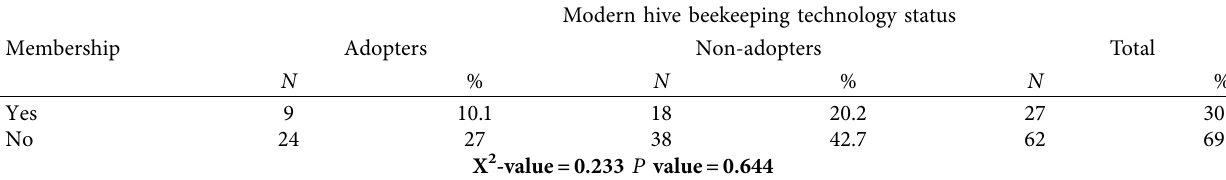
Table 14: Distribution of membership in cooperatives of respondents.